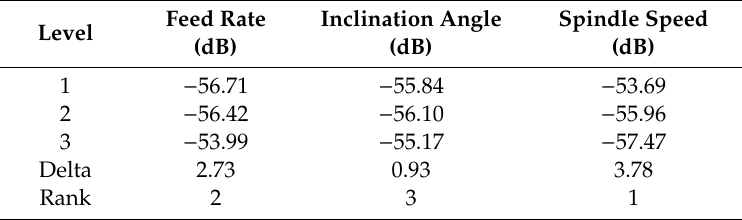
Figure 9. Cutting temperature captured ( a ) FE Simulation of 30 ◦ inclination angle (0.5 mm / rev, 1000 spindle rpm)( b )FESimulationof60 ◦ inclinationangle(0.5mm / rev, 2000spindlerpm)( c ) FE Simulation of 90 ◦ inclination angle (0.5 mm / rev, 3000 spindle rpm). Table 13. Response Table for S / N ratios for